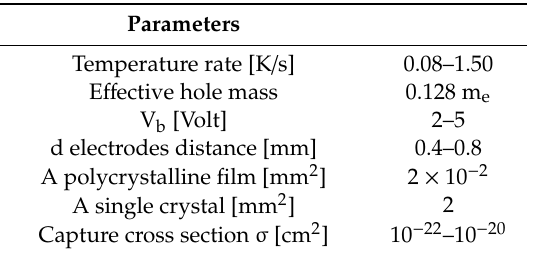
Table 1. Parameters used in the TSC